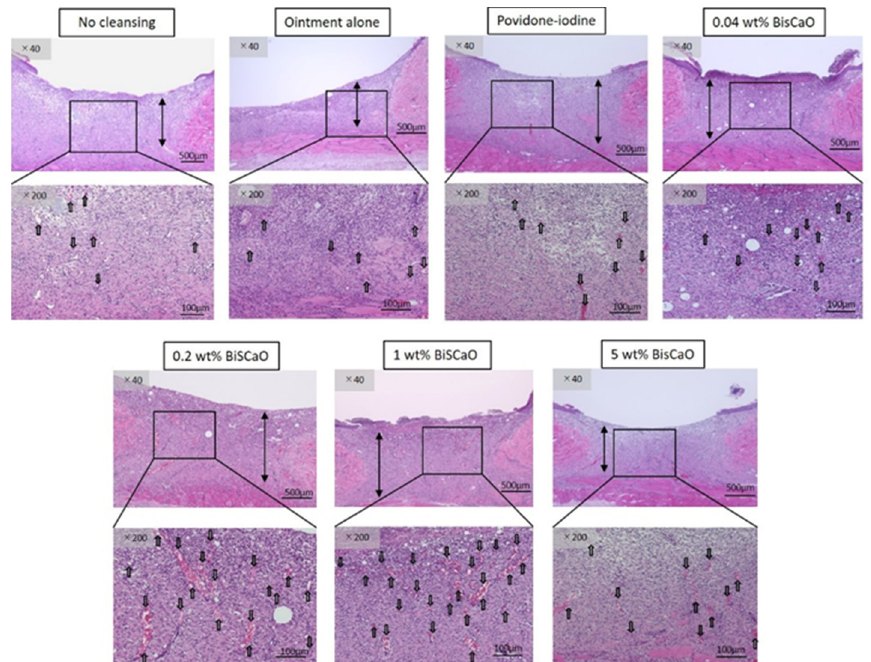
Figure 5. Histological examination of granulation tissue and capillary formation in each treatment group. The skin surrounding the infected wounds in each treatment group on Day 9 was harvested, processed for hematoxylin–eosin (H&E) staining, and microphotographed ( n = 6) (magnification: 40 × , 200 × ), the arrows show blood vessels.